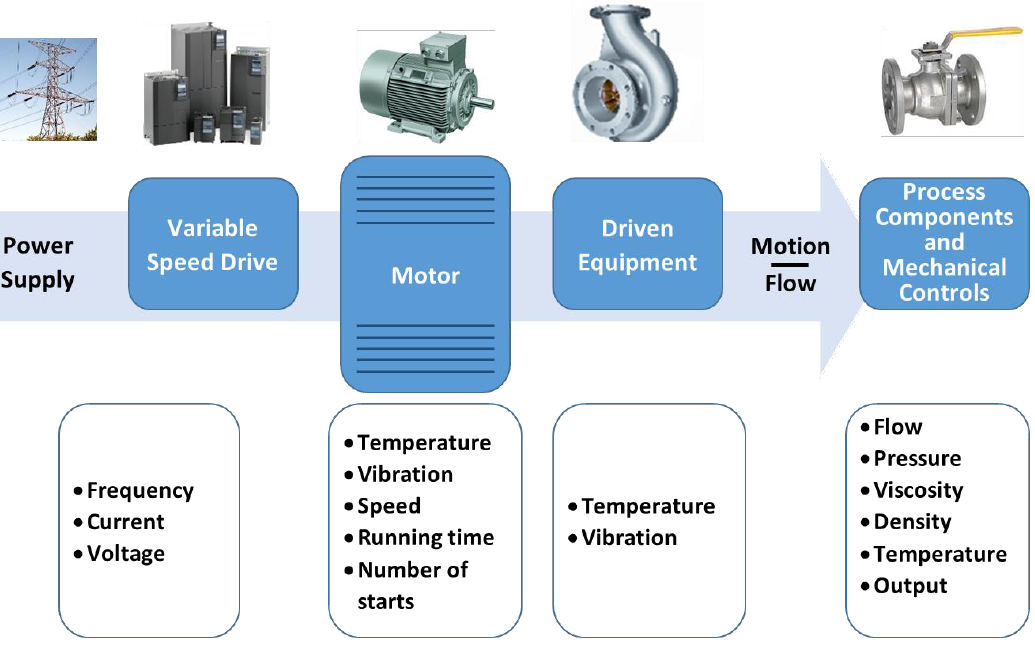
Figure 9. Potential areas of measurements and of application of sensors in motor driven systems (Source: Authors adapted from [30]).